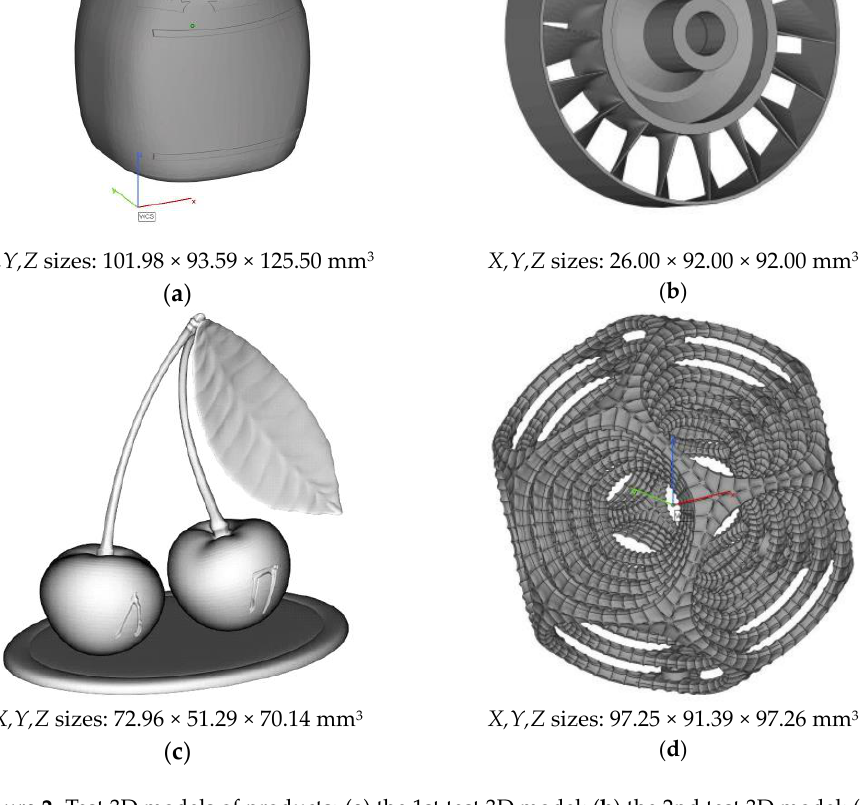
Figure 2. Test 3D models of products: ( a ) the 1st test 3D model; ( b ) the 2nd test 3D model; ( c ) the 3rd test 3D model; ( d ) the 4th test 3D model.